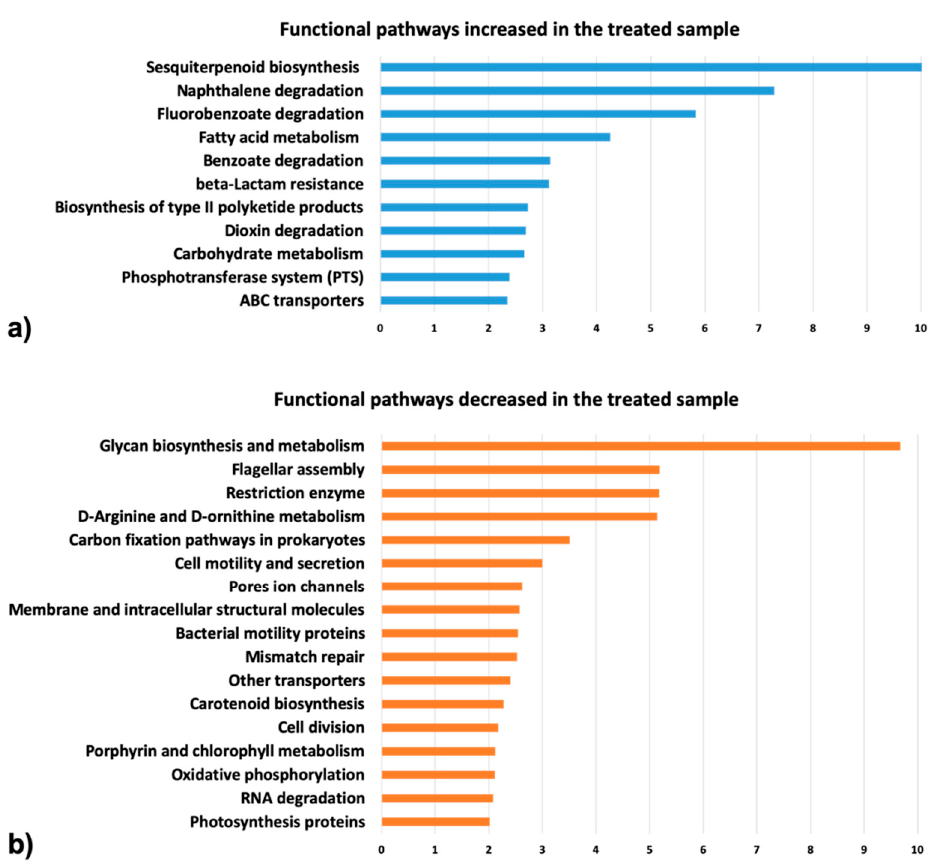
Figure 8. Functional pathways differentially enriched in the treated sample. The metabolic pathways that increased and decreased at least two-fold in the treated biofilm are represented in panels ( a ) and ( b ), respectively. Ratios higher than 2 were reported in the graphs.